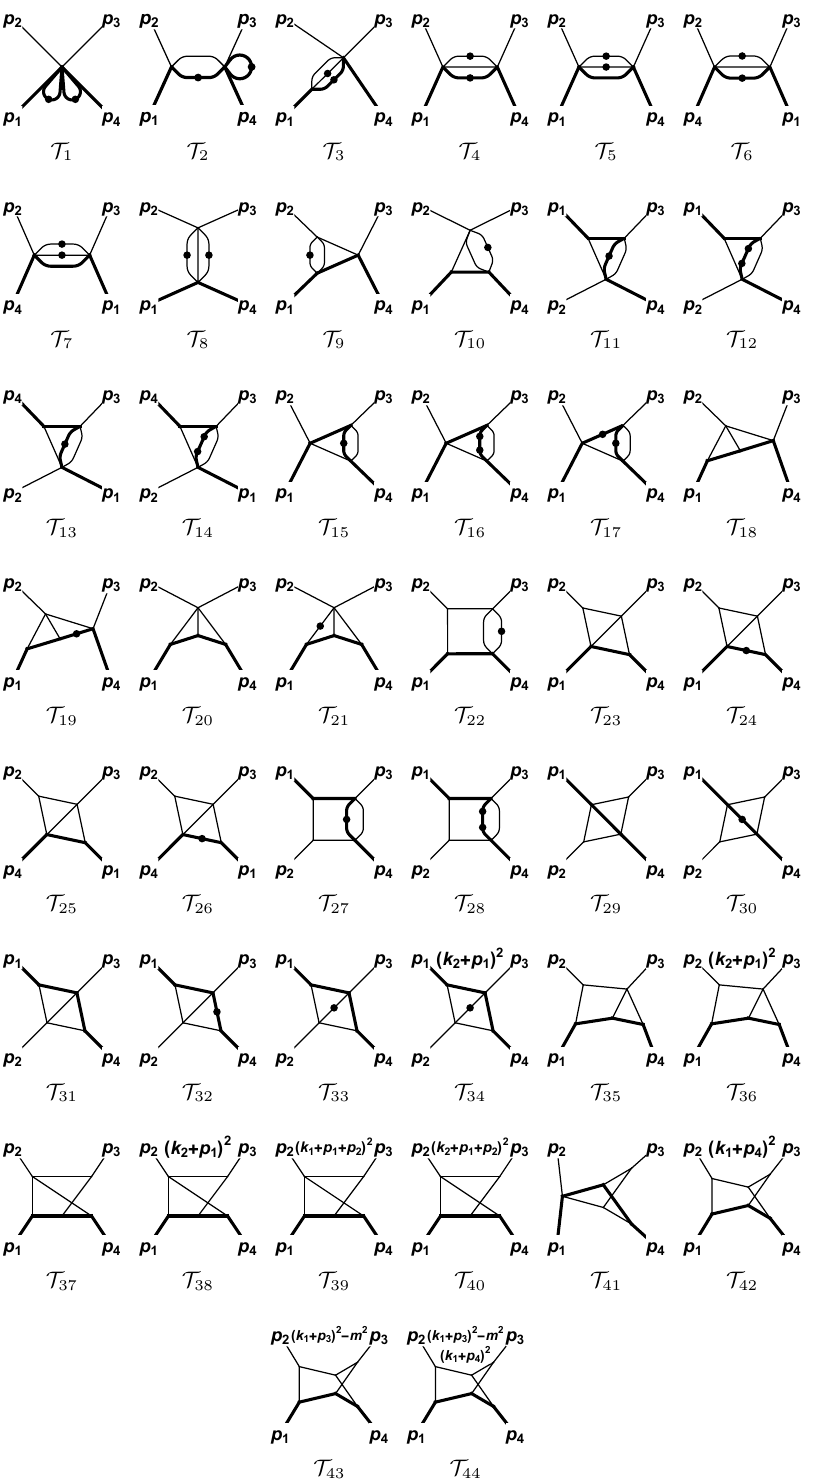
Figure 2. The 44 MIs T for the two-loop non-planar topology T 1 ;:::; 44 massless propagators and thick lines stand for massive ones. Each dot indicates an additional power of the corresponding propagator. Numerator insertions are indicated explicitly on top of each diagram.